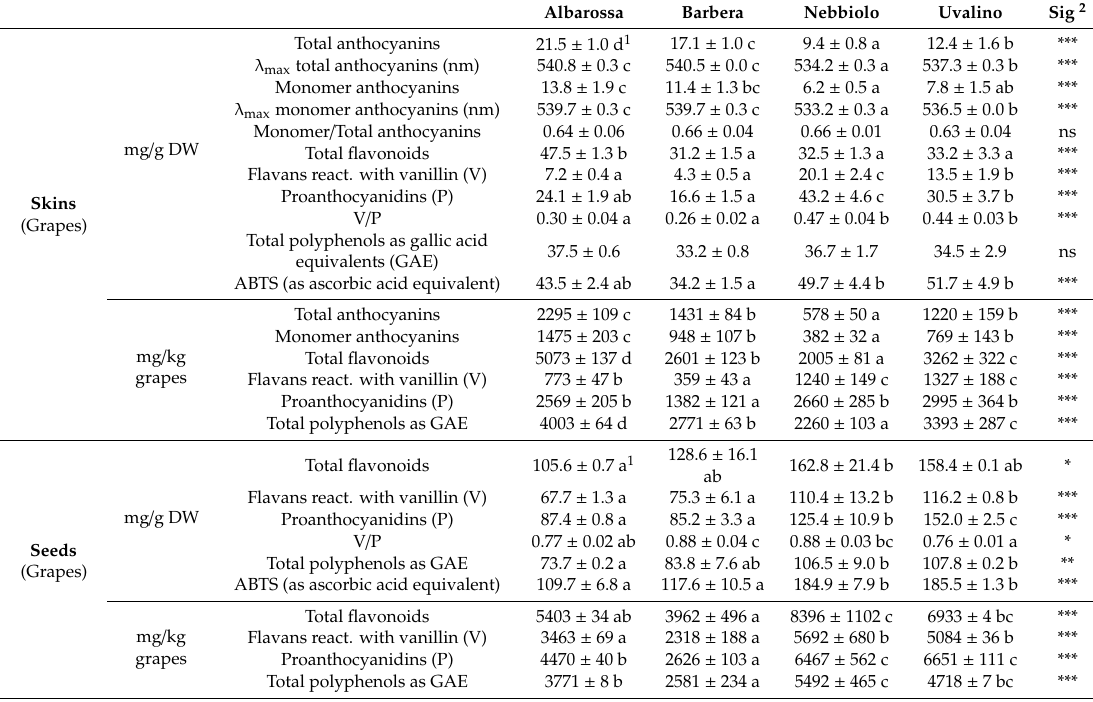
Phenolic composition (by spectrophotometry) of the skin and seed extracts expressed as mg / g dry weight (DW) and mg / kg grapes. Antioxidant power ((2,2’-azinobis-(3- ethylbenzothiazoline-6-sulfonate)) (ABTS) method) of the grape skin and seed extracts, expressed as ascorbic acid equivalent in mg / g DW. Standard deviations and ANOVA